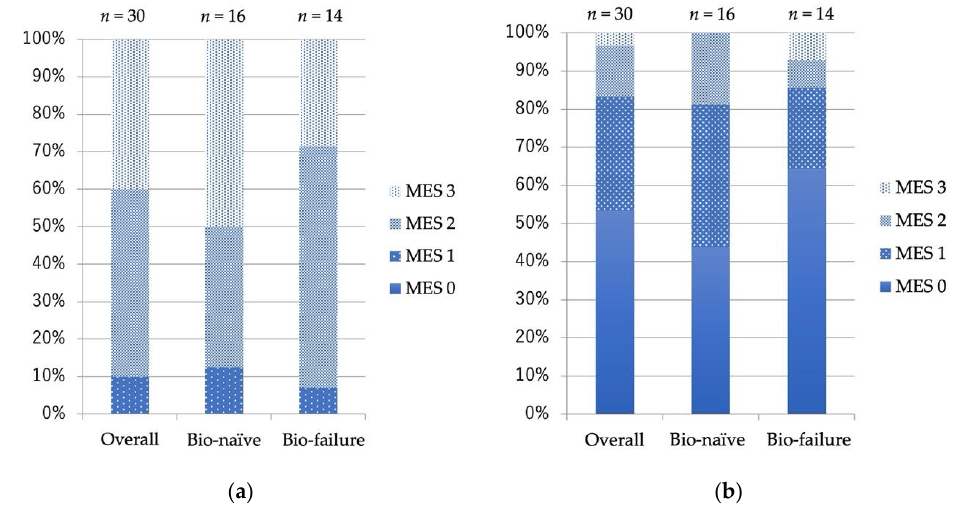
Figure 2. Endoscopic evaluation of patients treated with Vedolizumab at ( a ) baseline, and ( b ) at 52 weeks after Vedolizumab administration. Endoscopic severity was assessed using the Mayo endoscopic score. MES: Mayo endoscopic